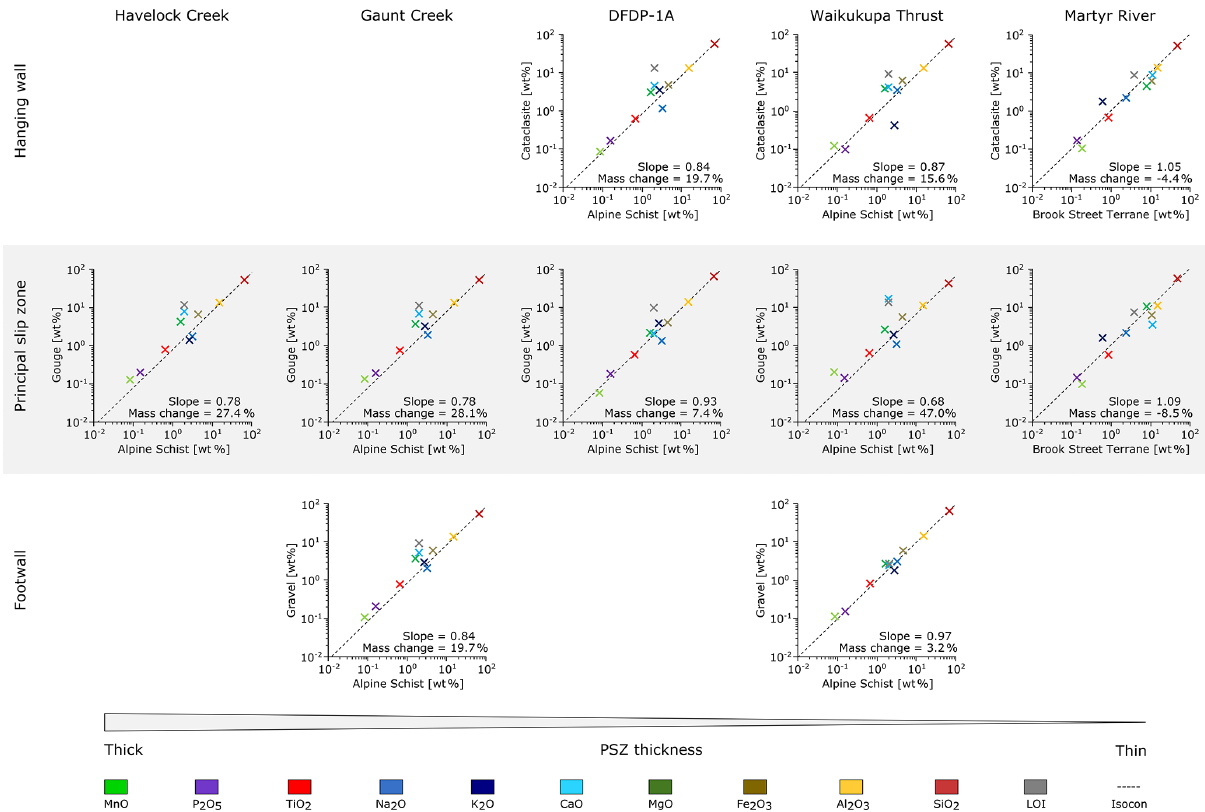
Figure 9. Isocon analysis of locations investigated. In the case of multiple measurements per structural unit (hanging wall, PSZ, footwall), data were averaged to derive single values. Values are given in Table S1.